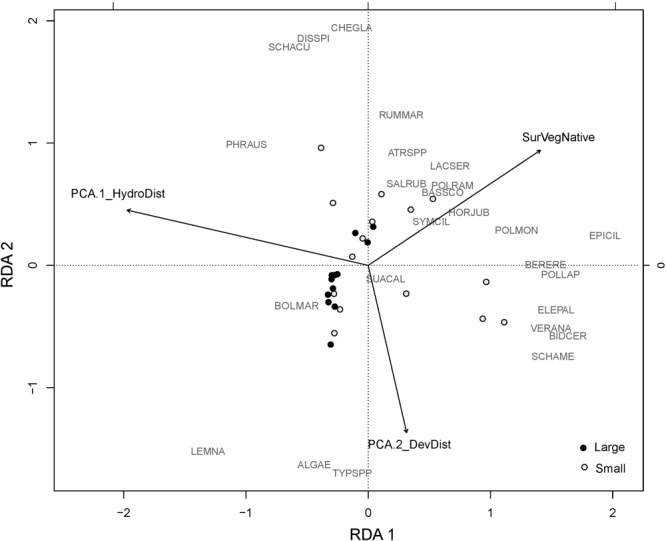
RDA of the plant community from 2015 with the significant landscape variables overlaid. Large plots are marked by black dots. Small plots are marked by open white dots. The RDA vectors are PCA.1_HydroDist: Landscape PCA 1 representing nearby hydrologic disturbances like canals and impoundments; PCA.2_DevDisturbance: Landscape PCA2 representing nearby disturbance from nearby human developments; SurVegNative: percent cover of native perennial species in the surrounding vegetation of each plot. For species codes, refer to Figure 5.